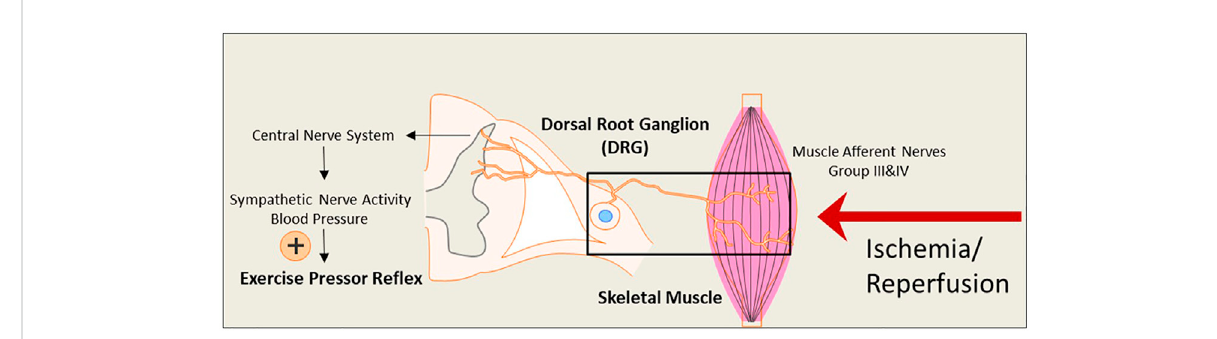
An illustrative diagram of the exercise pressor re fl ex (EPR) and the hypothesized impact of the ischemia-reperfusion on the neural pathway leading to the re fl ex. During exercise, the EPR is initiated as thin fi ber afferents arising from contracting skeletal muscle. The signals sensed by the nerve terminals embedded in the skeletal muscle are transmitted through the primary sensory neurons of dorsal root ganglion (DRG) to cardiovascular nuclei in the brain stem. The sympathetic nerve activity (SNA) and blood pressure (BP) are therefore increased. Under ischemia- reperfusion conditions, metabolites are elevated in the affected skeletal muscle. This is likely to amplify the receptors in muscle afferent nerves responsive to muscle metabolites and exaggerate the